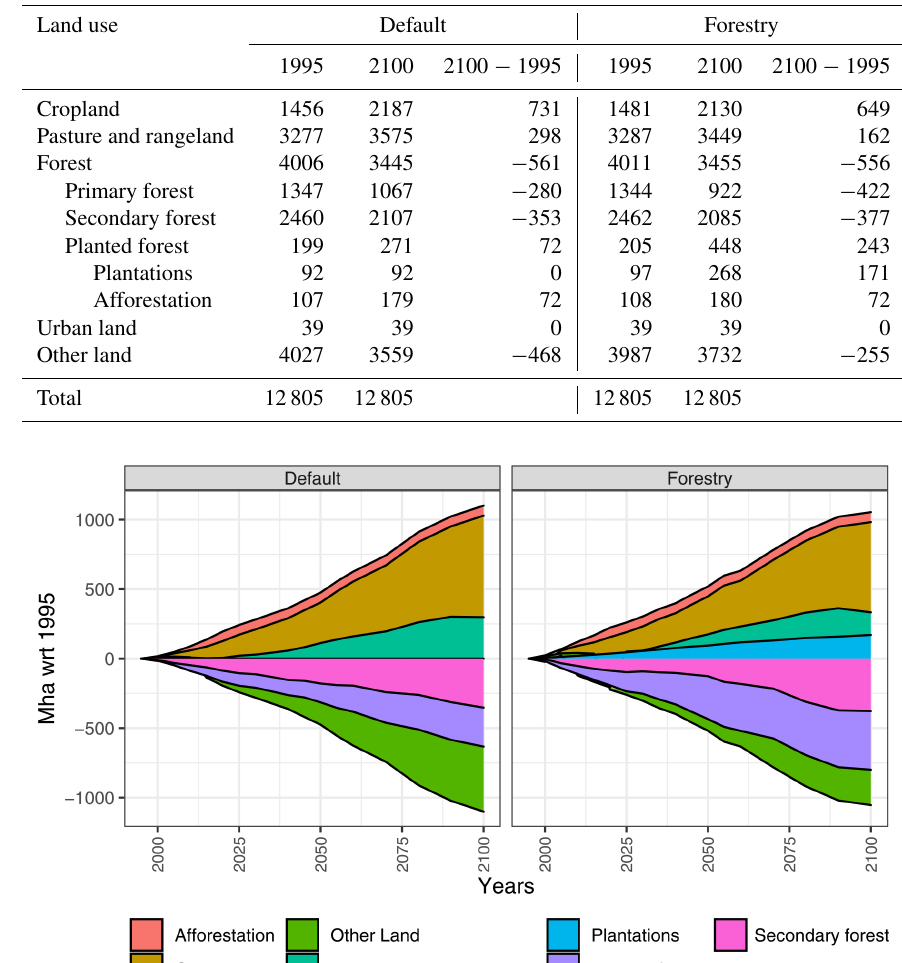
Table 2. Modeled land-use change between 1995 and 2100 (in Mha).